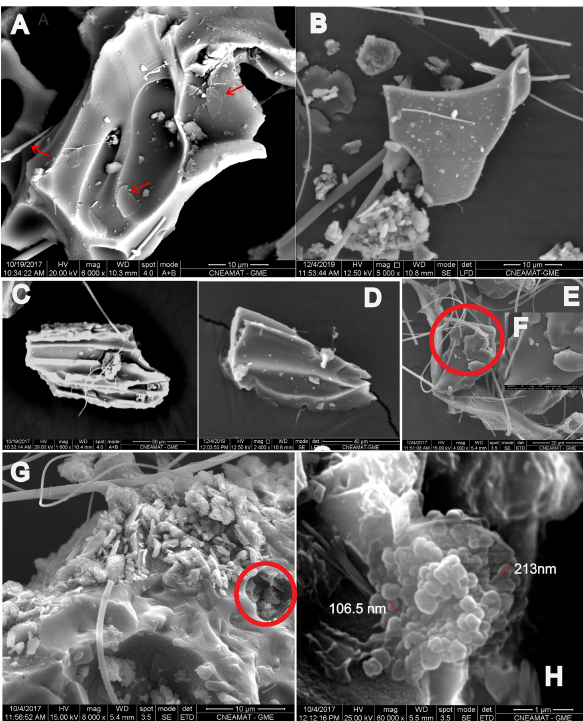
Figure 7. Scanning electron microscopy images of samples col- lected on Alerce Glacier. (a) Irregular glass fragment with low vesicularity; evidence of bubble coalescence, and small, flat, platy, very thin glass shards indicated by red arrows, loosely adhering to the grain surface. These tiny fragments are remnants of burst vesi- cle walls. (b) Glass fragment with smooth surface. (c) Glass frag- ment, with remnant of parallel pipe vesicles; notice the thin vesi- cle walls. (d) Y-shaped glass fragment, remnant of a partially bro- ken pumiceous pyroclast with elongated parallel bubbles. (e) Glass fragment with smooth surface. (f) Closeup of the glass fragment in (e) , showing in detail the smooth surface. (g) Portion of a vitric pyroclast with loose material on its surface (adhering dust), mostly tiny glass fragments, and a vesicle indicated by a red circle which contains small particles. (h) Closeup of the vesicle filling in (g) , showing an aggregate of carbon spherules of 100 to 200nm corre- sponding to black carbon (BC)